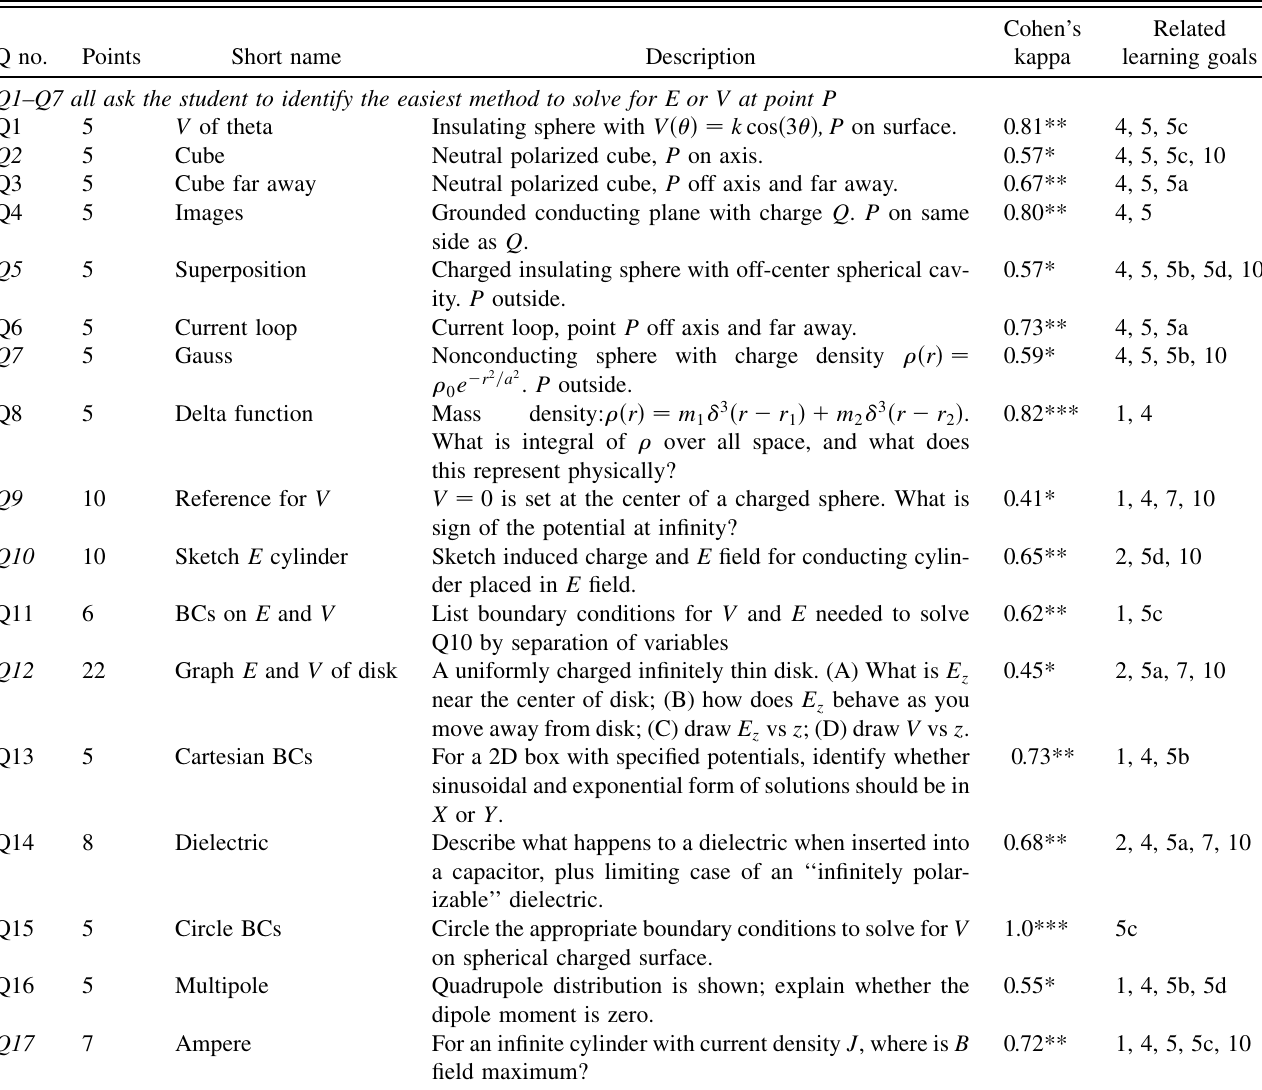
TABLE I. All problems on the CUE, including point allocations, Cohen’s kappa (see Sec. III B), and learning goal alignment. Question numbers in italics indicate items which are on the pretest. Cohen’s kappa values are designated as ‘‘moderate’’ (*; 0.41–0.60), ‘‘substantial’’ (**; 0.6–0.80), or ‘‘almost perfect’’ (***; 0.81–1.0), as determined by Landis and Koch [22]. Relevant learning goals are provided for illustrative purposes and are not intended to be